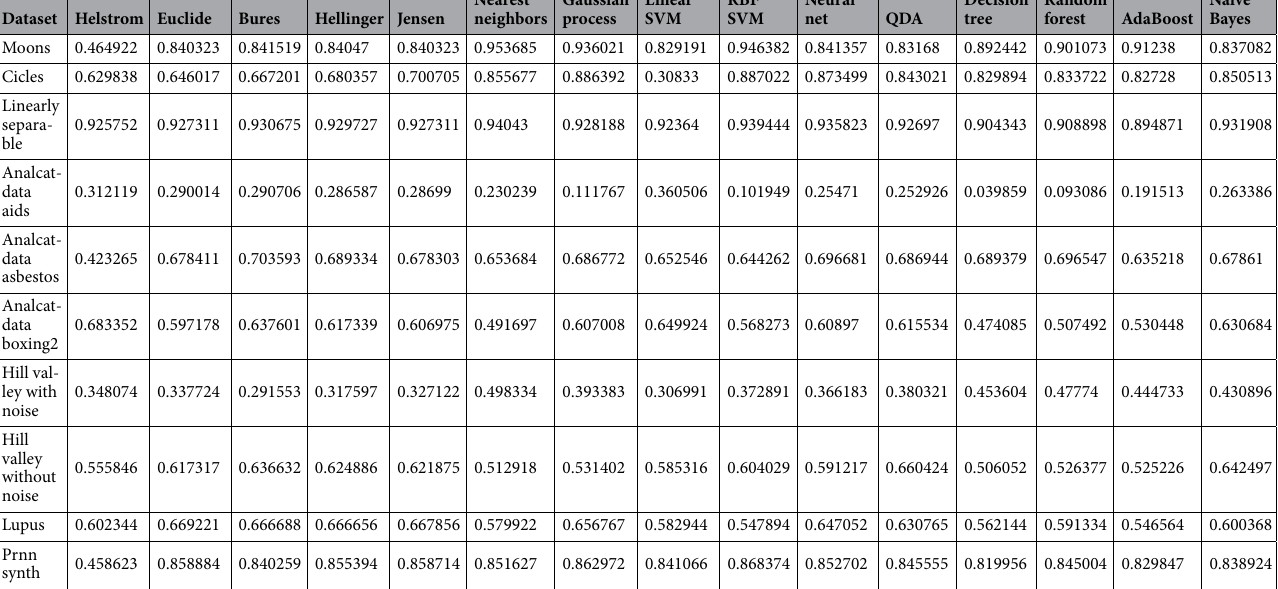
Table 2. F 1-score with the first 2